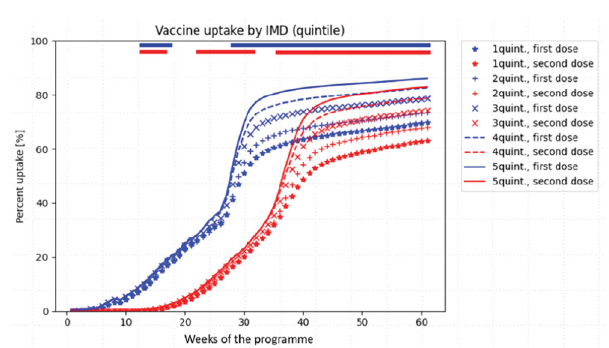
Fig. 3 | COVID-19 vaccine uptake by the index of multiple deprivation, nor- malised for date of vaccine availability by age group. The non-parametric Mood ’ s median test was used to compare the time to vaccination trajectories by IMD group; a two-sided P value was considered to be statistically signi fi cant was <0.001,correctedformultipletestingusingtheconservativeBonferronicorrection (i.e., 3.23×10 − 6 for IMD). Whilst it was not feasible to present 95% CI for vaccine uptake trajectories and maintain readability, the statistical analyses accounted for trajectoryvariabilitywithingroups.Thebarsatthetopofthe fi gurerepresenttime periods with signi fi cant differences in vaccine uptake by IMD, at the P <3.23×10 − 6 level. Blue bars represent the fi rst vaccination dose, and red bars second vaccina- tion dose. Quintile 1 of the IMD represents the most deprived segment of the population. IMD (Index of Multiple